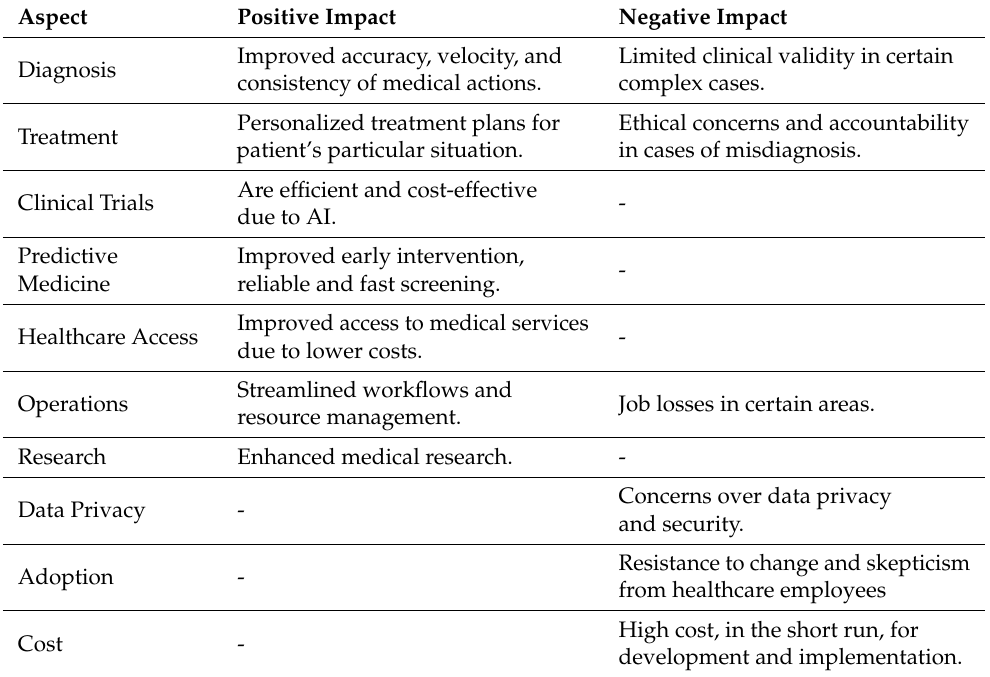
Table 3. The positive and negative aspects of healthcare affected by AI as a disruptive